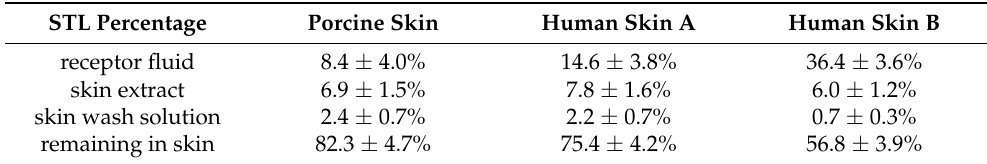
Table 2. STL portions in receptor fluids, skin extracts, skin wash solutions and remaining portions at the end of the dermal absorption experiments (48 h) with porcine skin, human skin A and human skin B ( n =